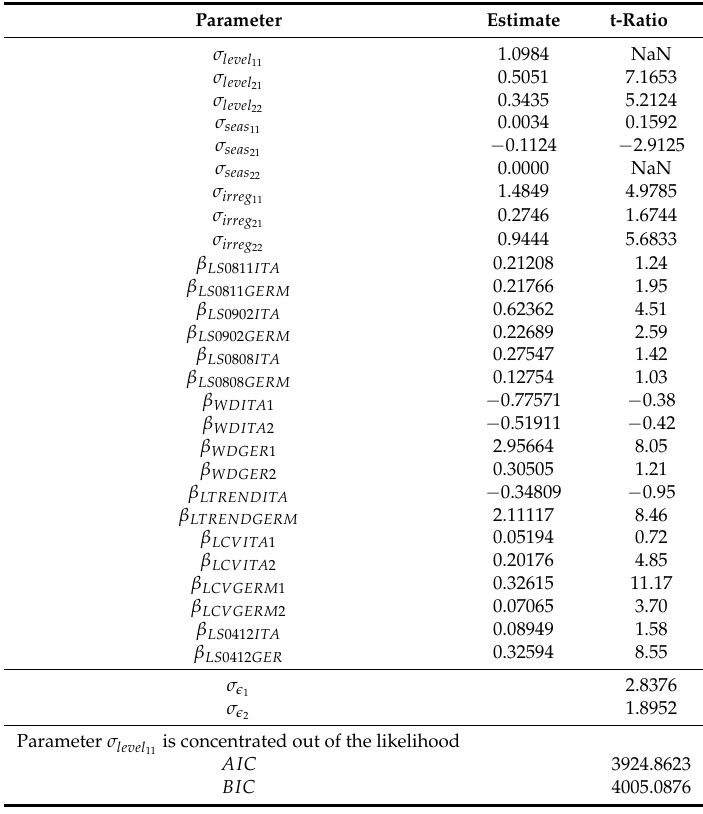
Table A10. Endogenous variables: IPI t capital goods TTMI t in Germany.